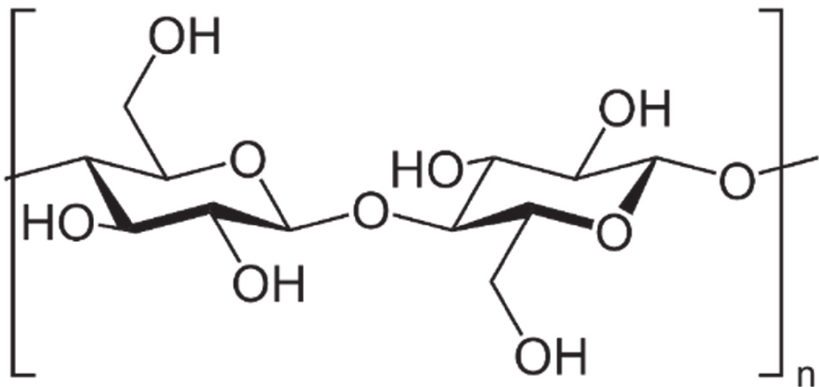
Figure 1. The chair conformation of β -anhydroxyglucose units in the cellulose chain. The nature of cellulose, and more specifically its chemical, physical and mechani- cal properties, as well as the fibrous structure, we can relate to its molecular